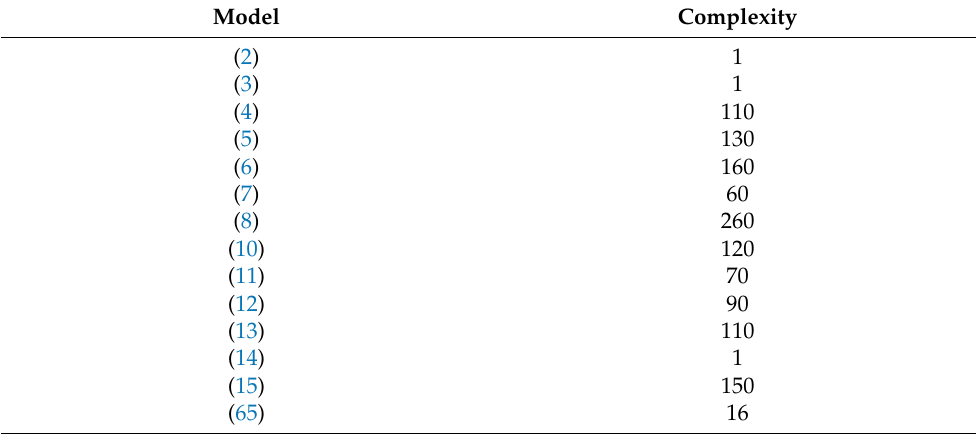
Table 6. Computational